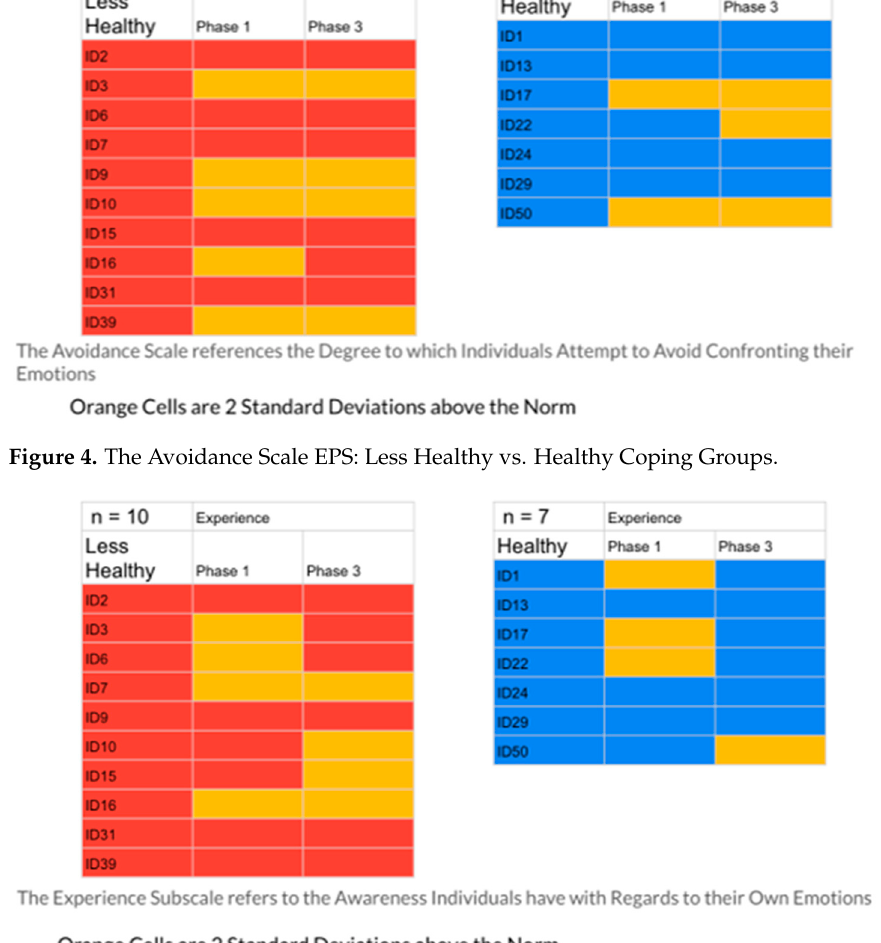
Figure 5. The Experience Scale EPS: Less Healthy vs. Healthy Coping Groups. Table 3. Means and standard deviations for the emotional processing subscales.